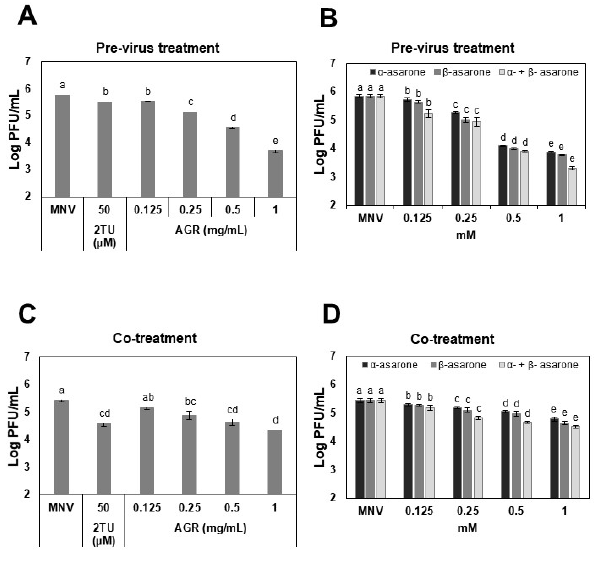
Figure 1. Antiviral effects of the AGR extract, α -asarone, and β -asarone against MNV. For the pre- treatment of MNV, ( A ) AGR extract (0.125–1 mg/mL), ( B ) α -asarone (0.125–1 mM), β -asarone (0.125– 1 mM), or a combination of α - and β -asarone (1:1 ratio, 0.125–1 mM) was incubated with the MNV suspension (7–8 log PFU/mL) at a 1:1 volume ratio at room temperature for 3 h. The incubated sus- pension was added to confluent RAW 264.7 cells. For the co-treatment, confluent cell monolayers were infected with 200 µL viral suspension (2–3 log PFU/mL) and simultaneously mixed with ( C ) AGR extract (0.125–1 mg/mL), ( D ) α -asarone (0.125–1 mM), β -asarone (0.125–1 mM), or a combina- tion of α - and β -asarone (1:1 ratio, 0.125–1 mM). The 2-thiouridin (2TU) and PBS were the positive and untreated controls, respectively. Different letters designate significant differences ( p < 0.05).